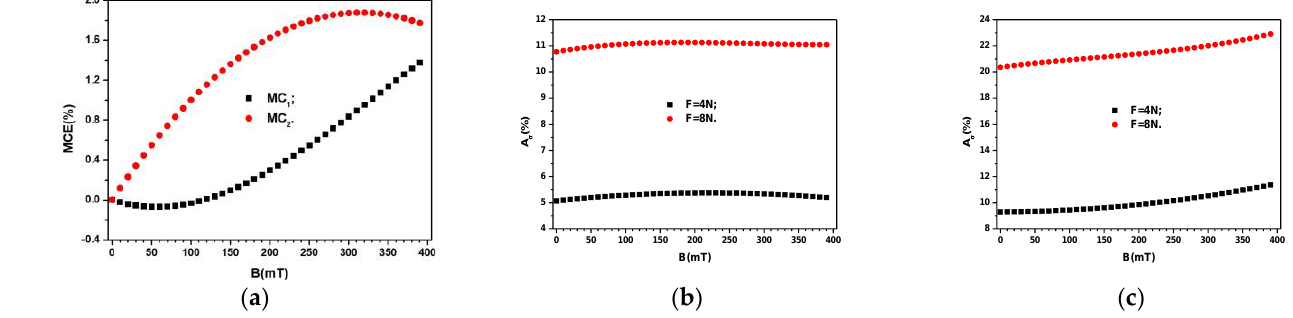
Figure 12. ( a ) Relative apparent MCE for MC 1 and MC 2 when 𝐹 ≠ 0N F. ( b ) The relative contribution 𝛢 σ for MC 1 . ( c ) The relative contribution 𝛢 σ for MC 2 .